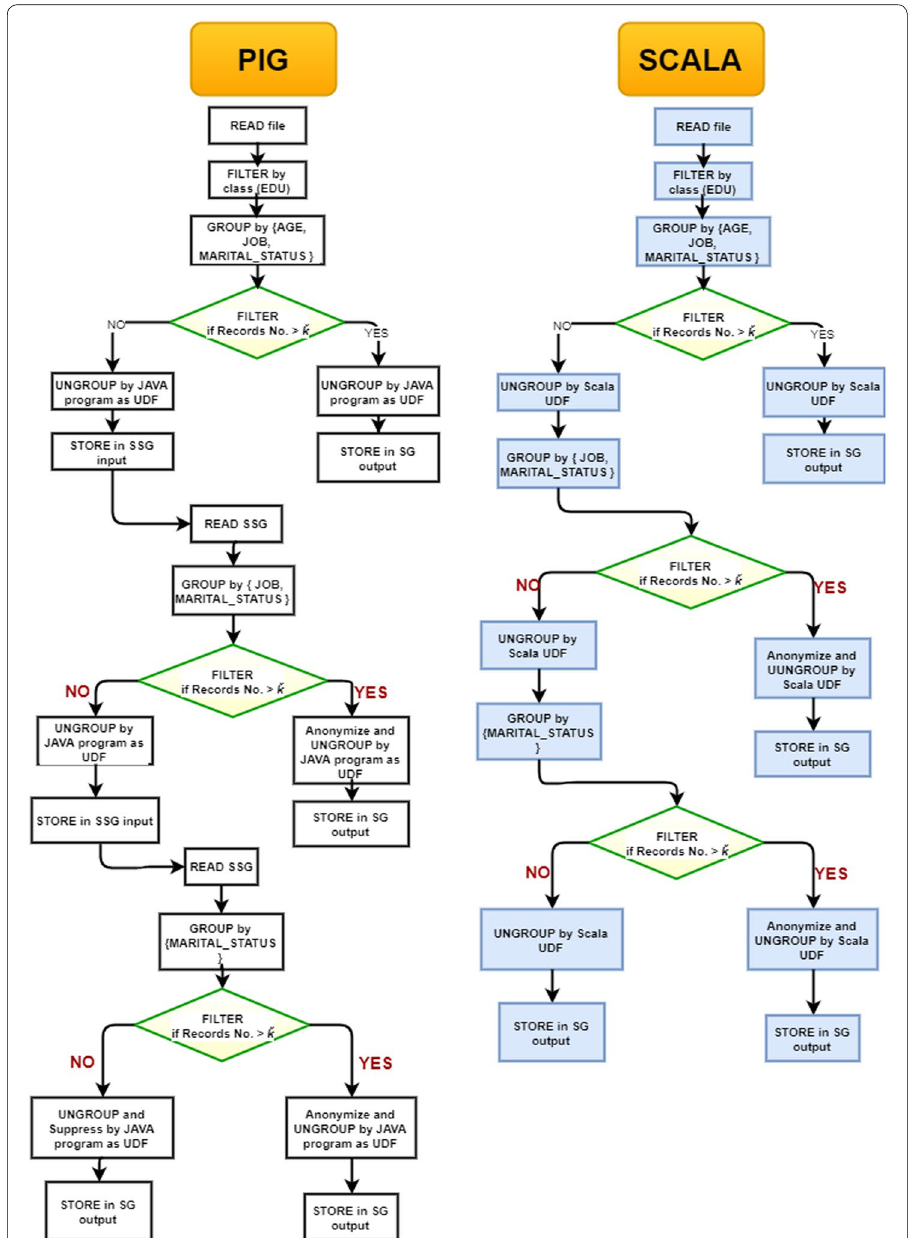
Fig. 5 Anonymization algorithms in Pig and Spark: very similar anonymization algorithms in Pig and Scala. Only minor differences between